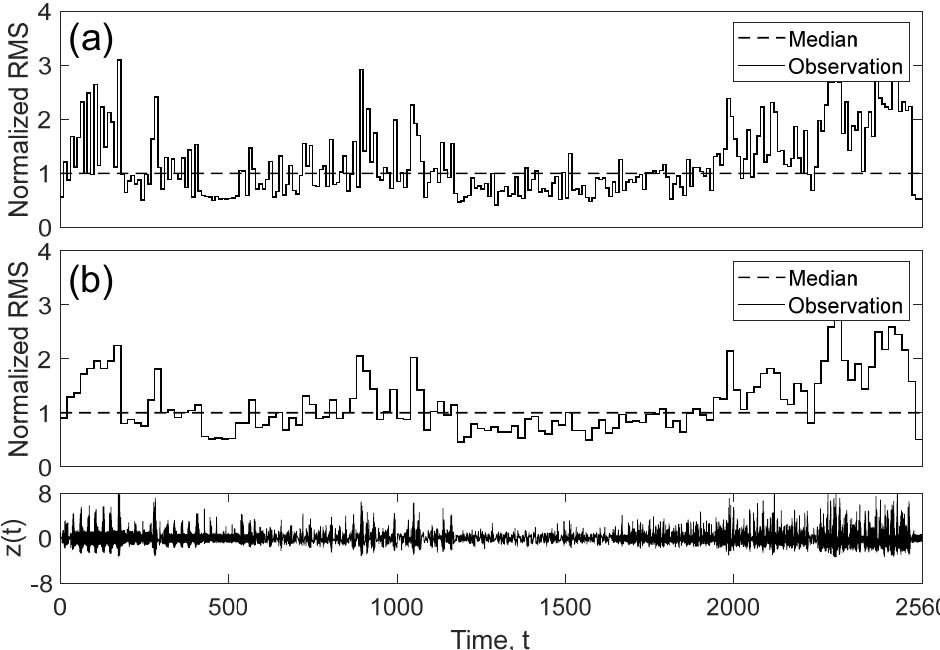
Figure 10. Run test method applied to the measured time history z ( t ) with two segment lengths (CH6 record, outer rim): ( a ) T s = 10 s and ( b ) T s = 20